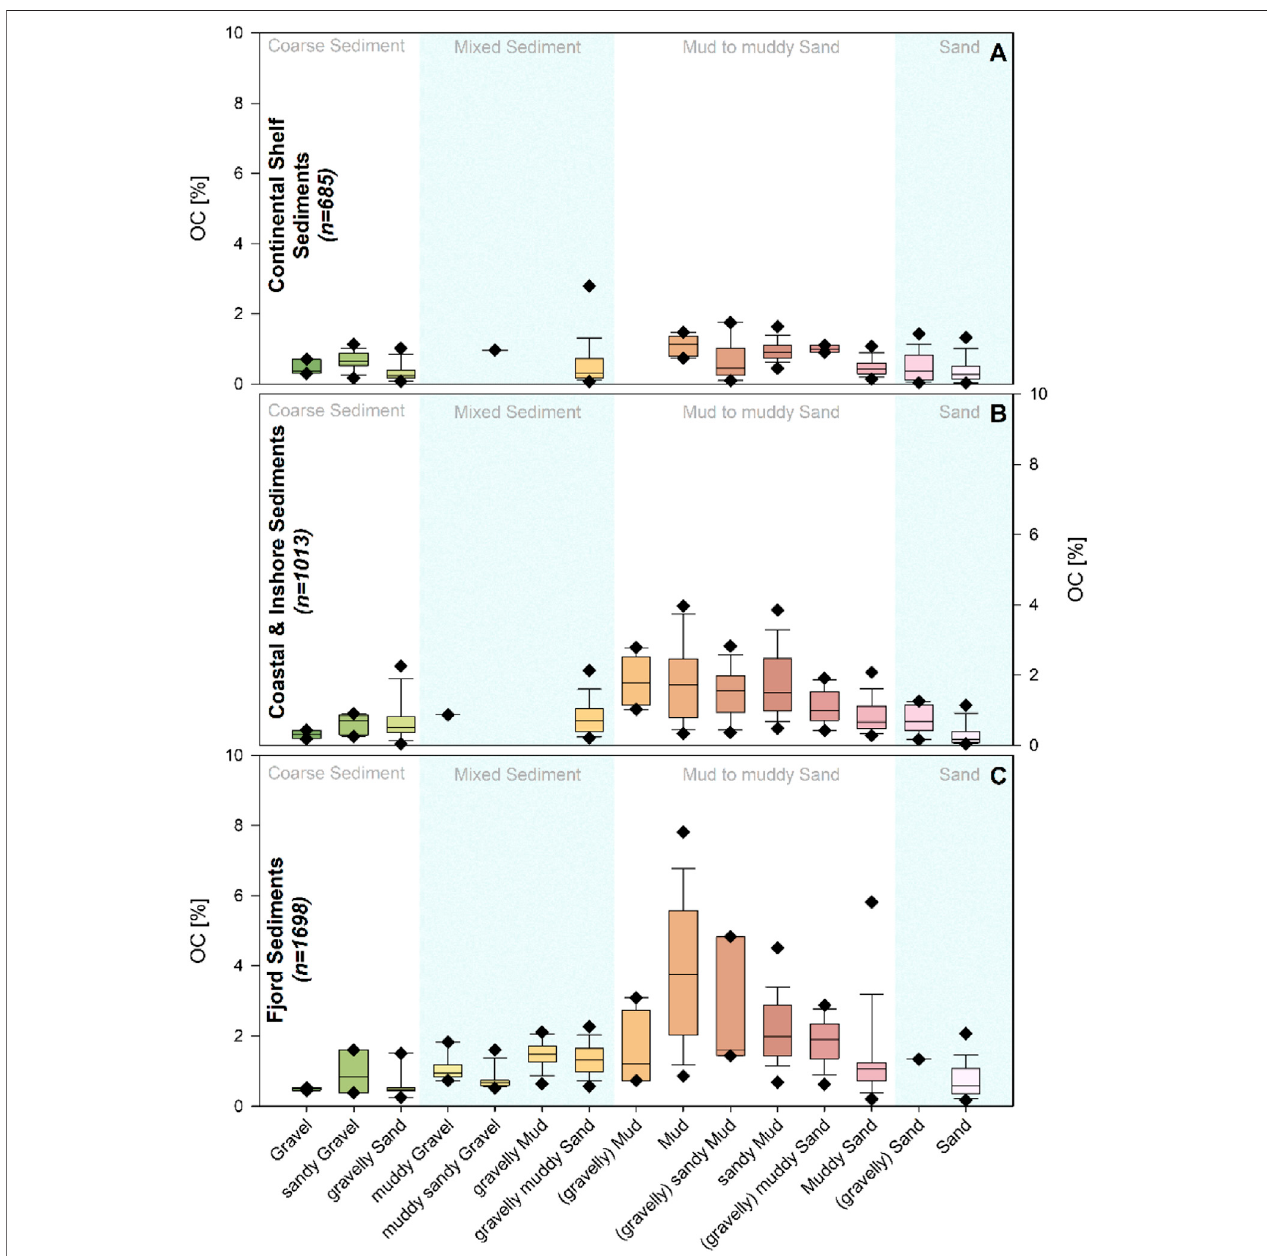
FIGURE5| OCcontent[%]acrossthe16sedimentclasses forthedifferent zonesoftheUKEEZ (A) Continentalshelfsediments( n (cid:2) 685 ) (B) Coastaland Inshore sediments ( n (cid:2) 1,013) (C) Fjord Sediments ( n (cid:2) 1,698 ).